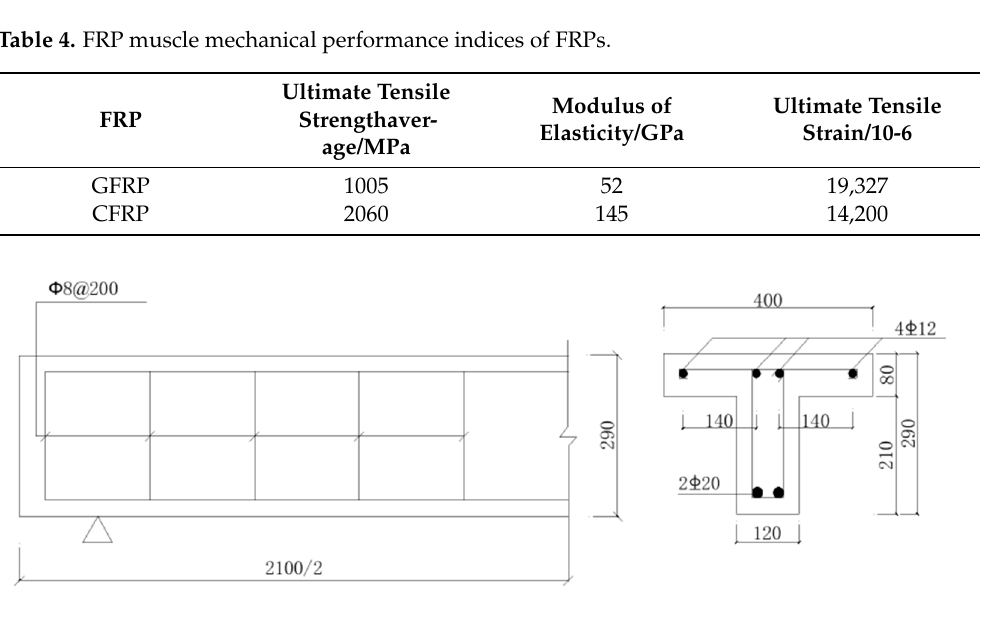
Table 5. Specimens grouping.